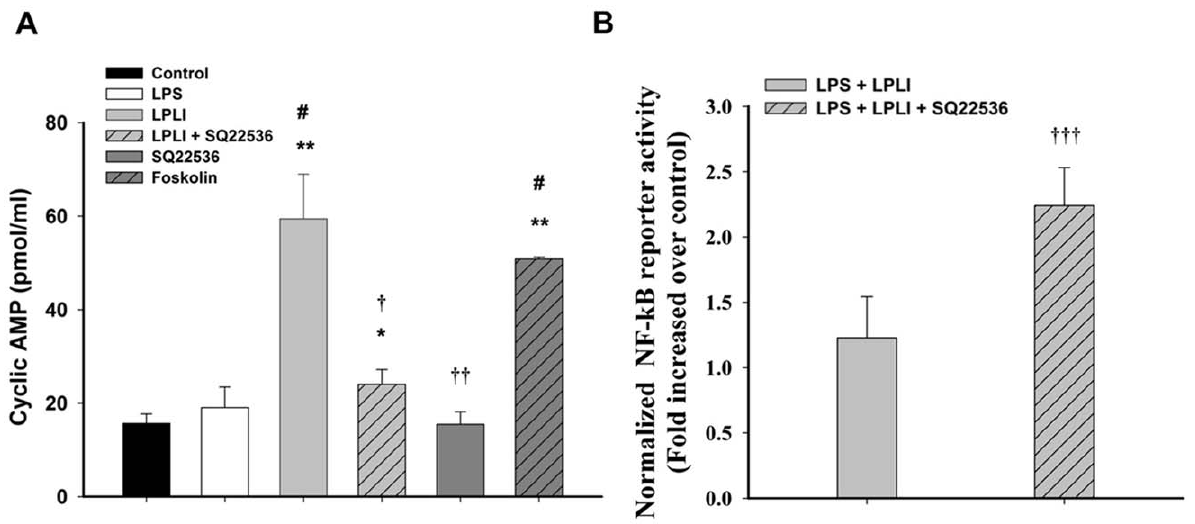
Figure 7. LPLI increases intracellular cAMP level to suppress NF- k B transcriptional activity. ( A ) Intracellular cAMP levels were measured by ELISA in hADSCs treated with LPS, LPLI, SQ22536, and forskolin. ( B ) NF- k B transcriptional activity was assayed 5 hours after LPLI treatment only and combined pretreatment of SQ22536. The data are expressed as the mean 6 SD (n=6). The following statistical levels were applied: *p , 0.05 and **p , 0.01 compared to the control, # p , 0.05 compared to LPS (50 ng/ml), and { p , 0.05, {{ p , 0.01, and {{{ p , 0.001 compared to LPLI (8 J/cm 2 ).